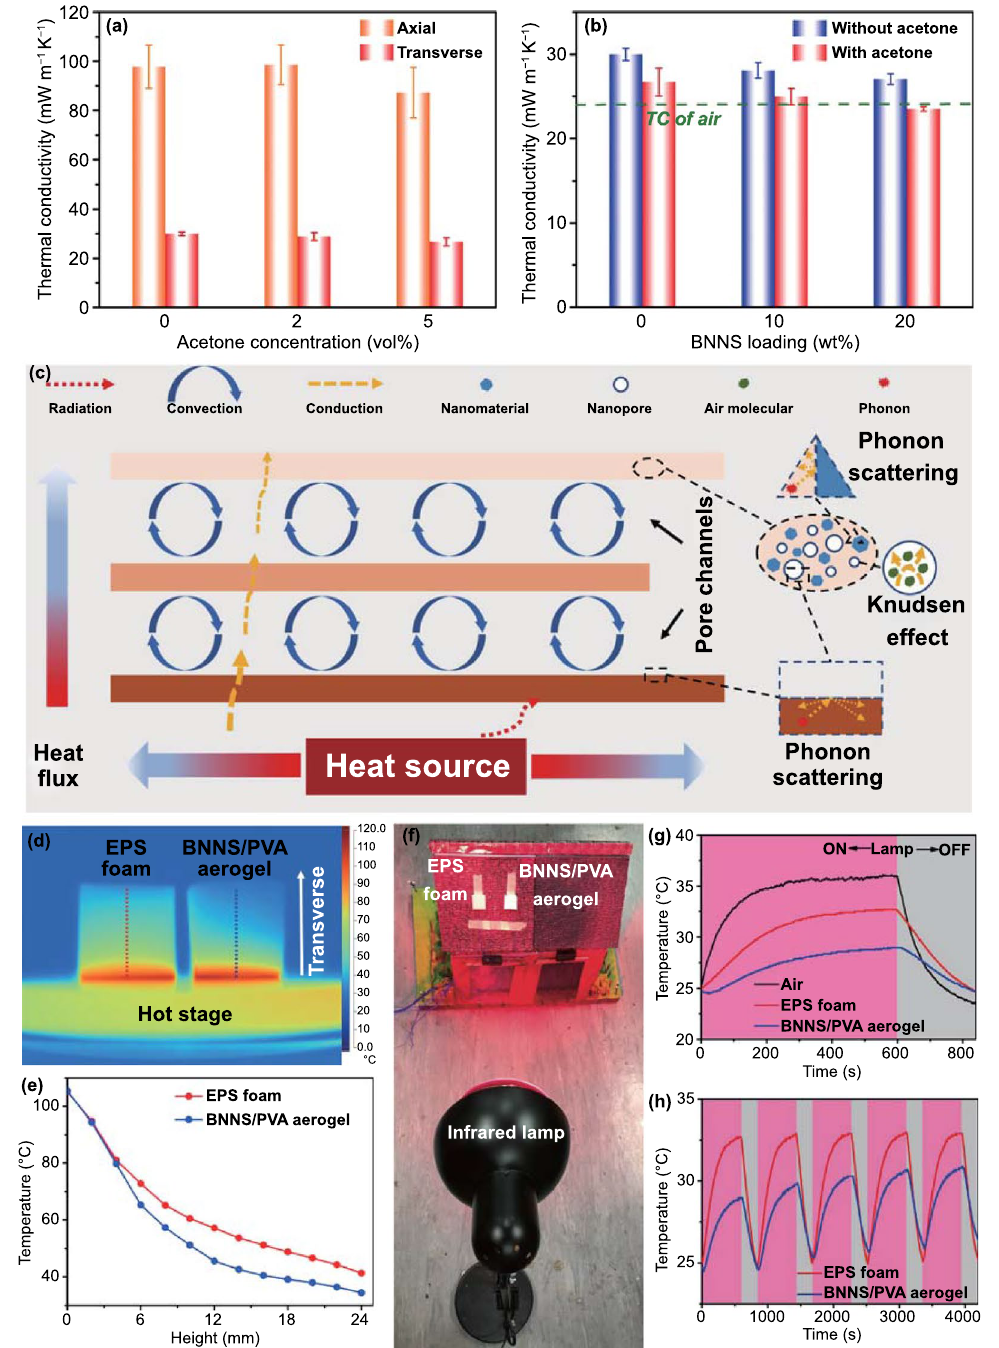
Fig. 3 TCs and thermal responses of the aerogels. TCs of a the PVA aerogels in the axial and transverse directions prepared with different acetone concentrations and b the BNNS/PVA composite aerogels prepared with different loadings of acetone and BNNSs in the transverse direc‑ tion. c Schematic illustration of the heat transfer process and working mechanism of the superinsulating BNNS/PVA composite aerogel. d Infra‑ red image and e temperature distributions of the BNNS/PVA composite aerogel and EPS foam when placed on a hot stage at 108 °C for 5 min. f Setup and g temperature changes of the BNNS/PVA composite aerogel and EPS foam when exposed to a non‑contact heat source from infrared lamp. h Temperature variations of the BNNS/PVA composite aerogel and EPS foam when subjected to five heating and cooling